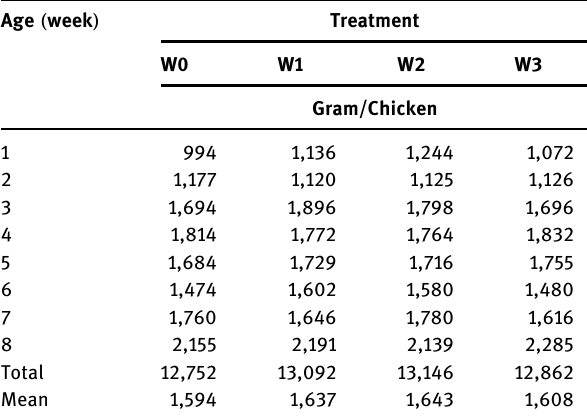
Table 2: Feed intake of chicken during 8 weeks of research